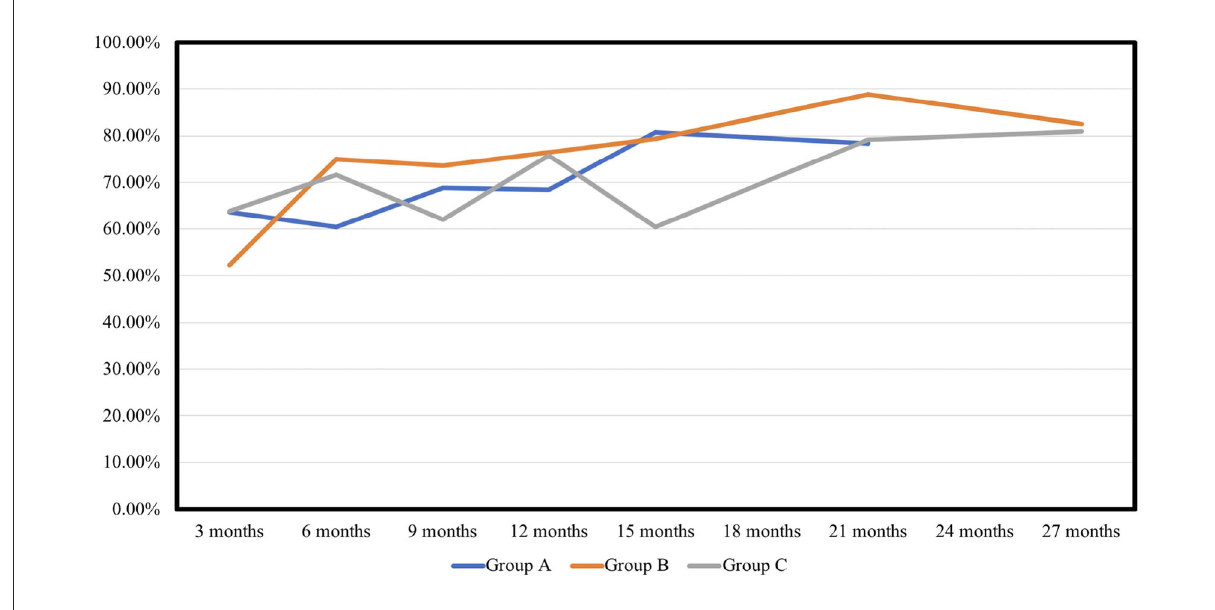
FIGURE1 Volume reduction rates of